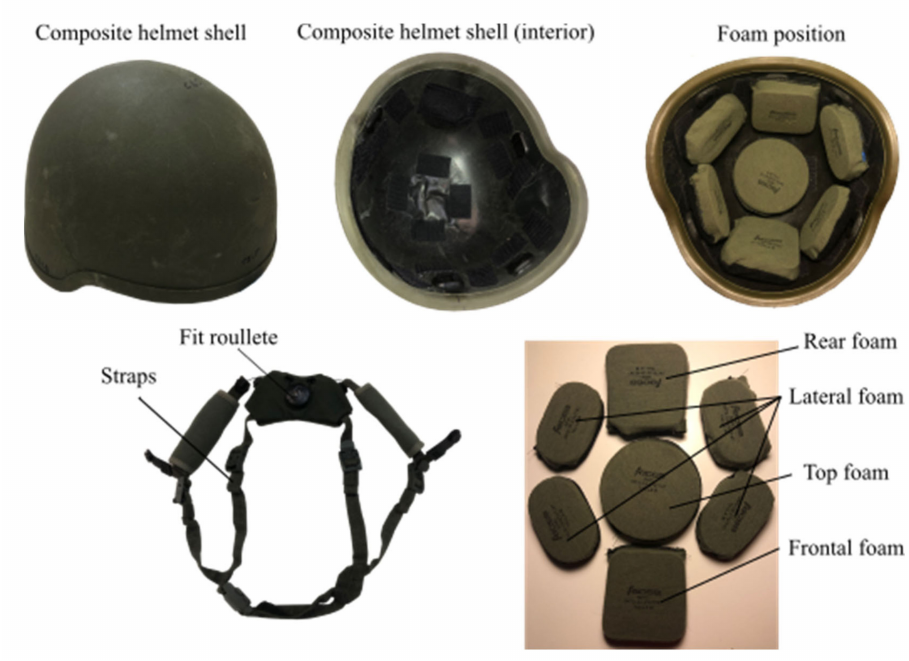
Figure 1. Combat helmet shell, foams, and